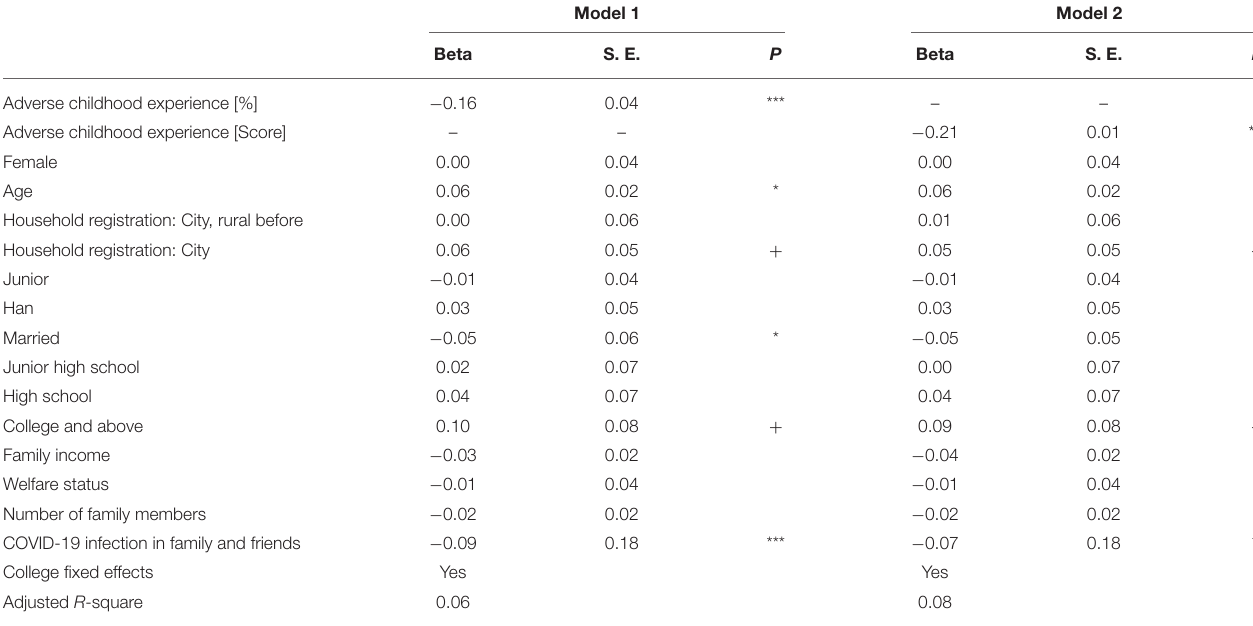
TABLE 3 | Multivariate regression analysis of mindfulness.